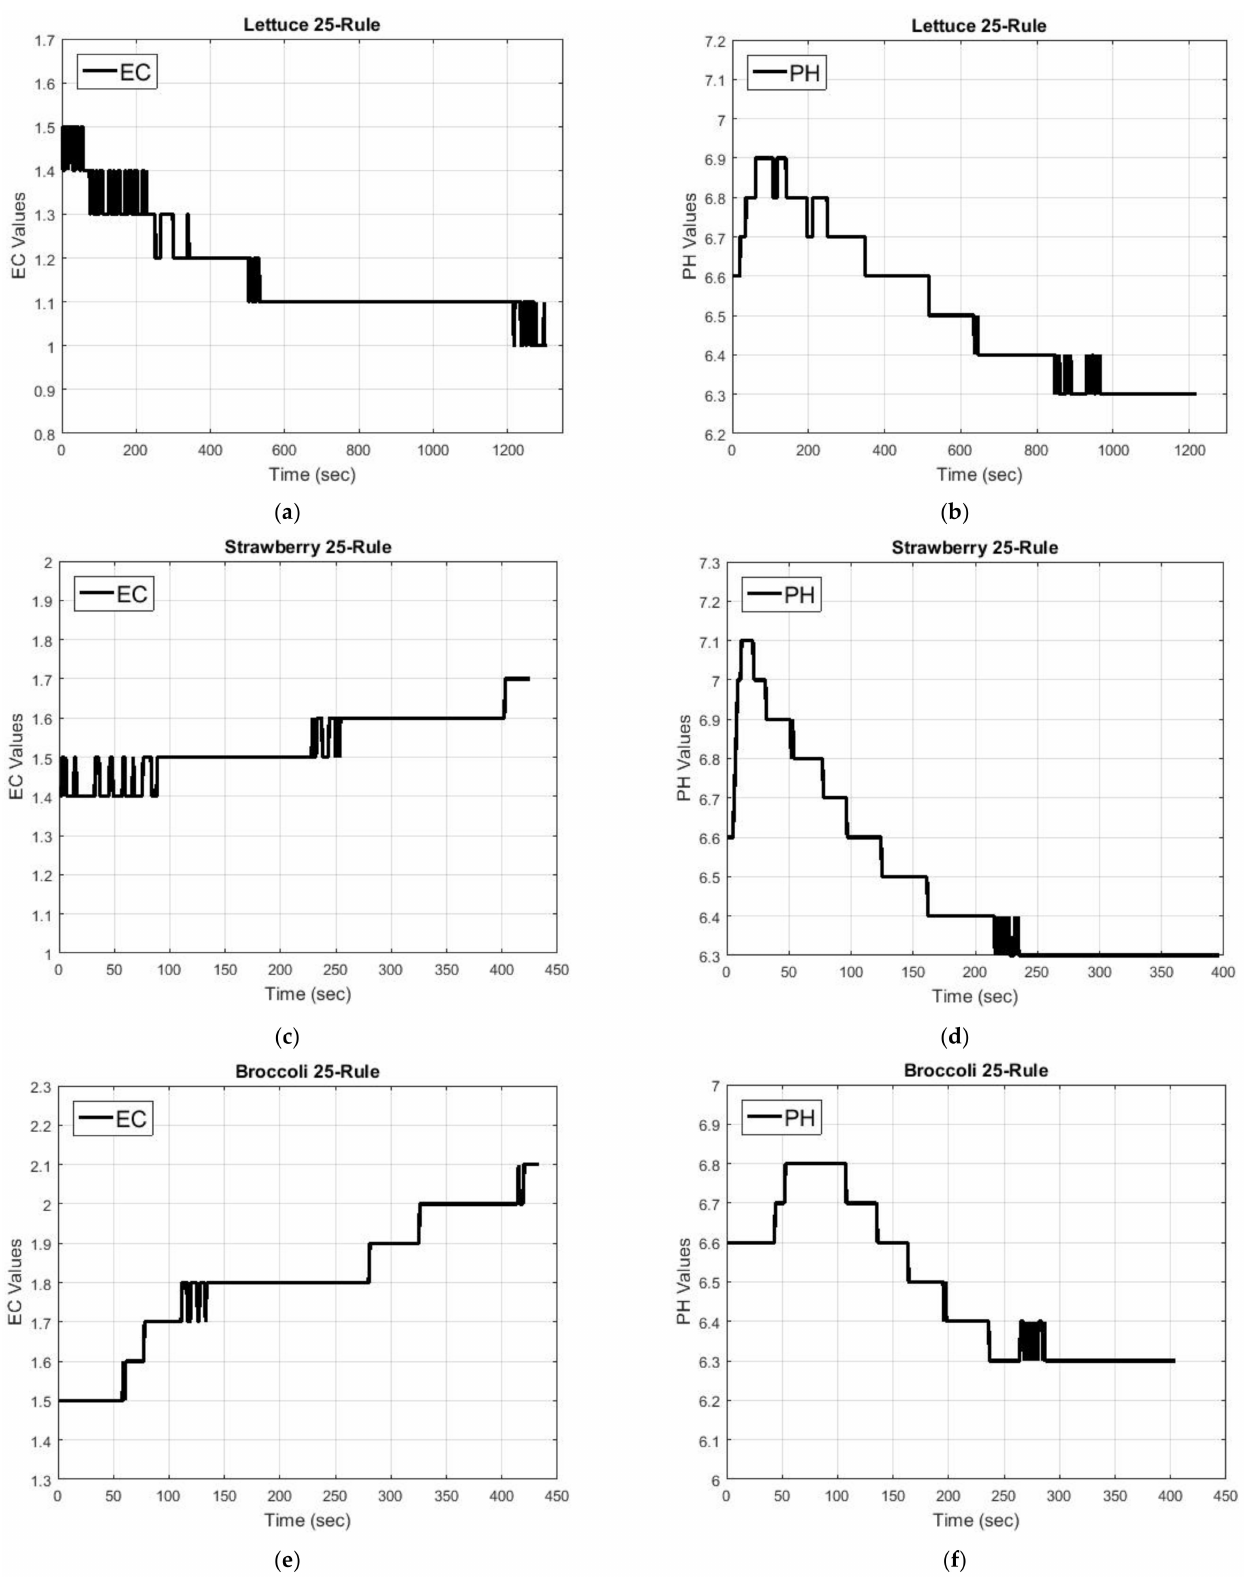
Figure 6. Results of the control of lettuce, strawberry, and broccoli by using 25 fuzzy rules. ( a ) Lettuce- EC; ( b ) Lettuce-PH; ( c ) Strawberry-EC; ( d ) Strawberry-PH; ( e ) Broccoli-EC; ( f )